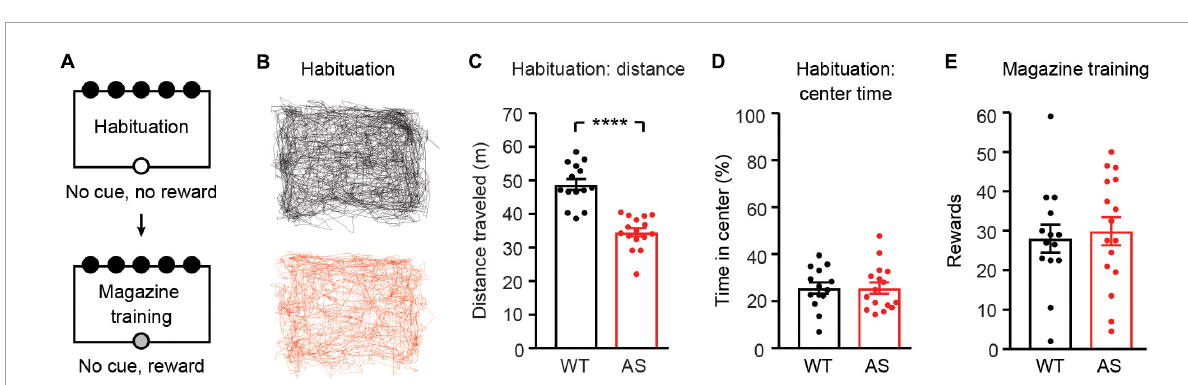
[ Figure 3D ; t ( 28 ) = 0.7584, p = 0.4545]. Ube3a m − / p + mice